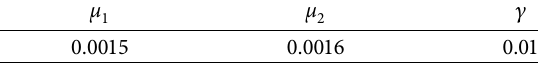
> 1. The malware persists in the 0